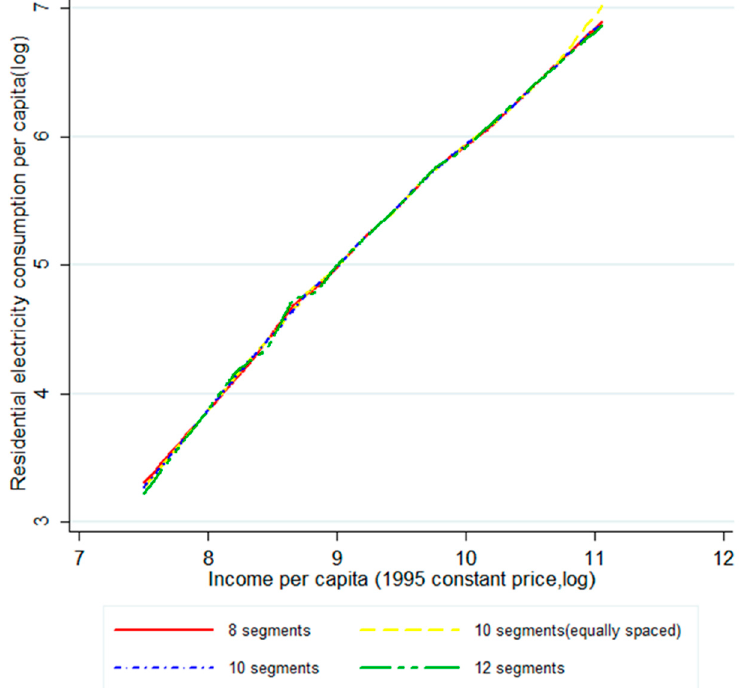
Figure 5. Estimated income effects using different segmentation. Note: 8 ‐ , 10 ‐ , 12 ‐ segment models are divided by percentile, and the 10 ‐ segment (equally spaced) model divides the income range into 10 intervals of equal width. The residential electricity consumption per capita on the vertical axis has been adjusted for the effect of income excluding the province ‐ fixed effect.